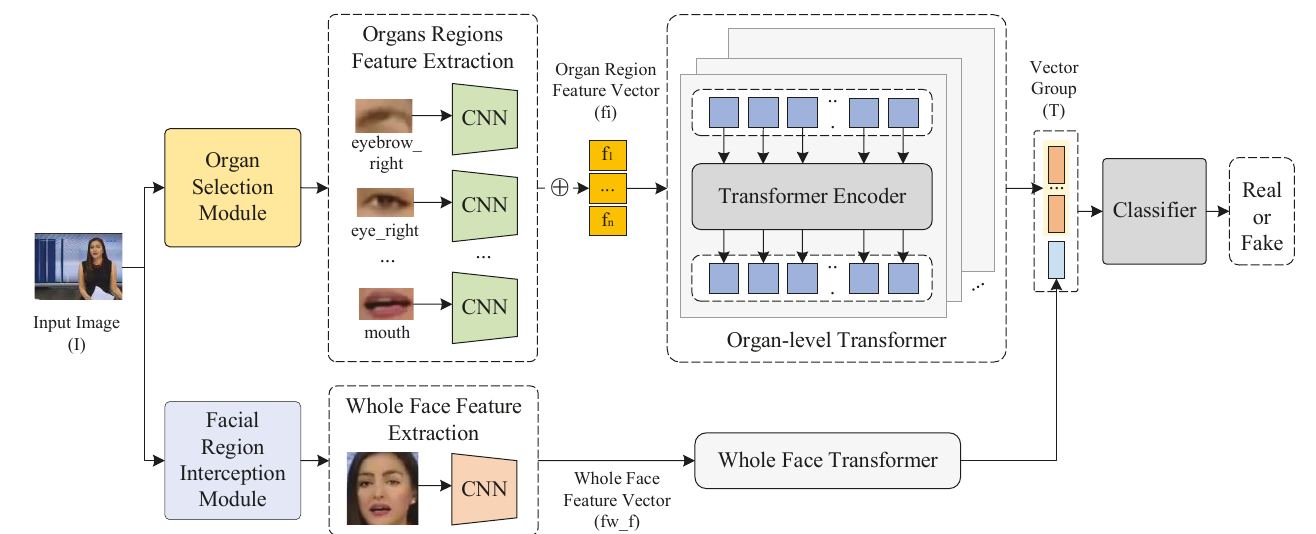
Figure 1. Our proposed method framework includes an organ-selection module, facial-region interception module, organ-level transformer, and classifier. The organ-selection module is mainly used to select clear organs and then utilizes the extractor to obtain features organ by organ. The facial-region interception module mainly frames the facial area and then uses the feature extractor to obtain the features of the whole face. Finally, we use a classifier to classify the results.